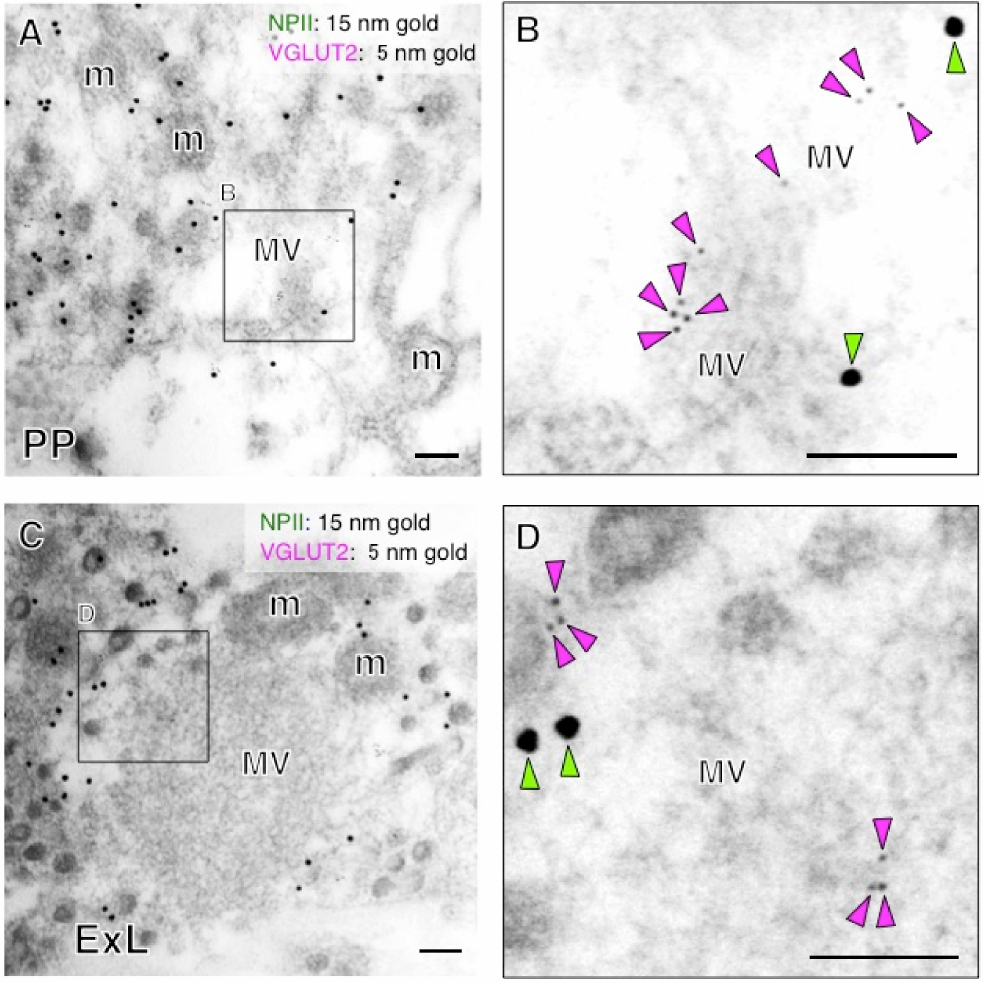
Figure 13. Immunoelectron microscopy for vesicular glutamate transporter 2 (VGLUT2) in the posterior pituitary (PP) ( A ) and external layer of the median eminence (ExL) ( C ) in a macaque monkey. ( B ) Double-label immunoelectron microscopy for vasopressin-associated neurophysin (NPII) and VGLUT2 shows that VGLUT2-immunoreactivity is associated with clustered microvesicles (MV) in the posterior pituitary. ( D ) Double-label immunoelectron microscopy for NPII/VGLUT2 in- dicates that VGLUT2-immunoreactivity is associated with the membrane of electron-lucent small vesicles in the vasopressin endings. The outlined areas are enlarged. Scale bars, 100 nm. Green arrowheads indicate NPII-immunoreactivity; magenta arrowheads indicate VGLUT2-immunoreactivity. m, mitochondrion; MV, clustered